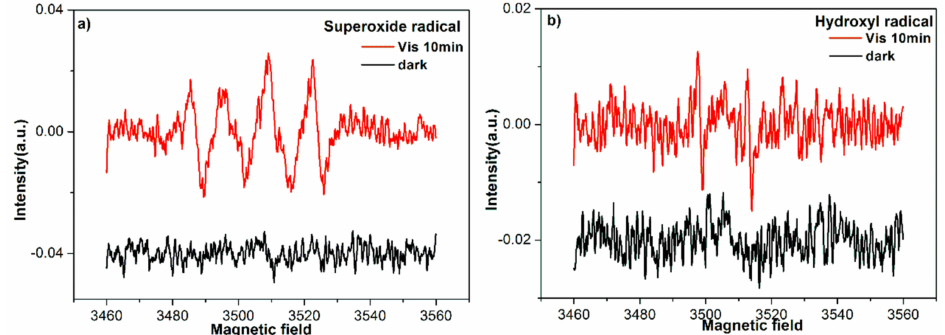
Figure 9. ESR spectra of 2Fe( Ш )-CN in aqueous solution before and after visible light